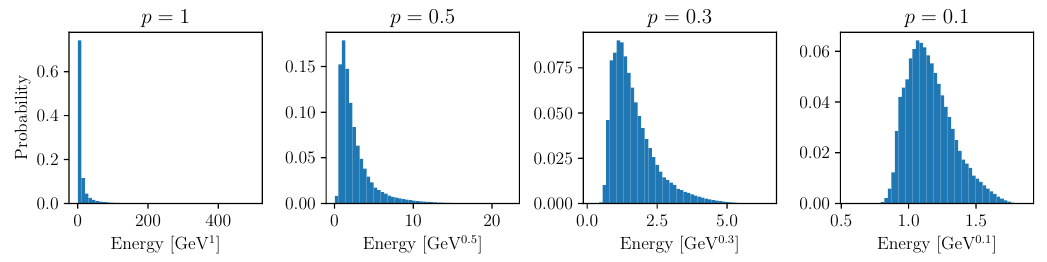
Figure 1: Distribution of energy deposition when pixel entries are raised by several different powers E → E p .